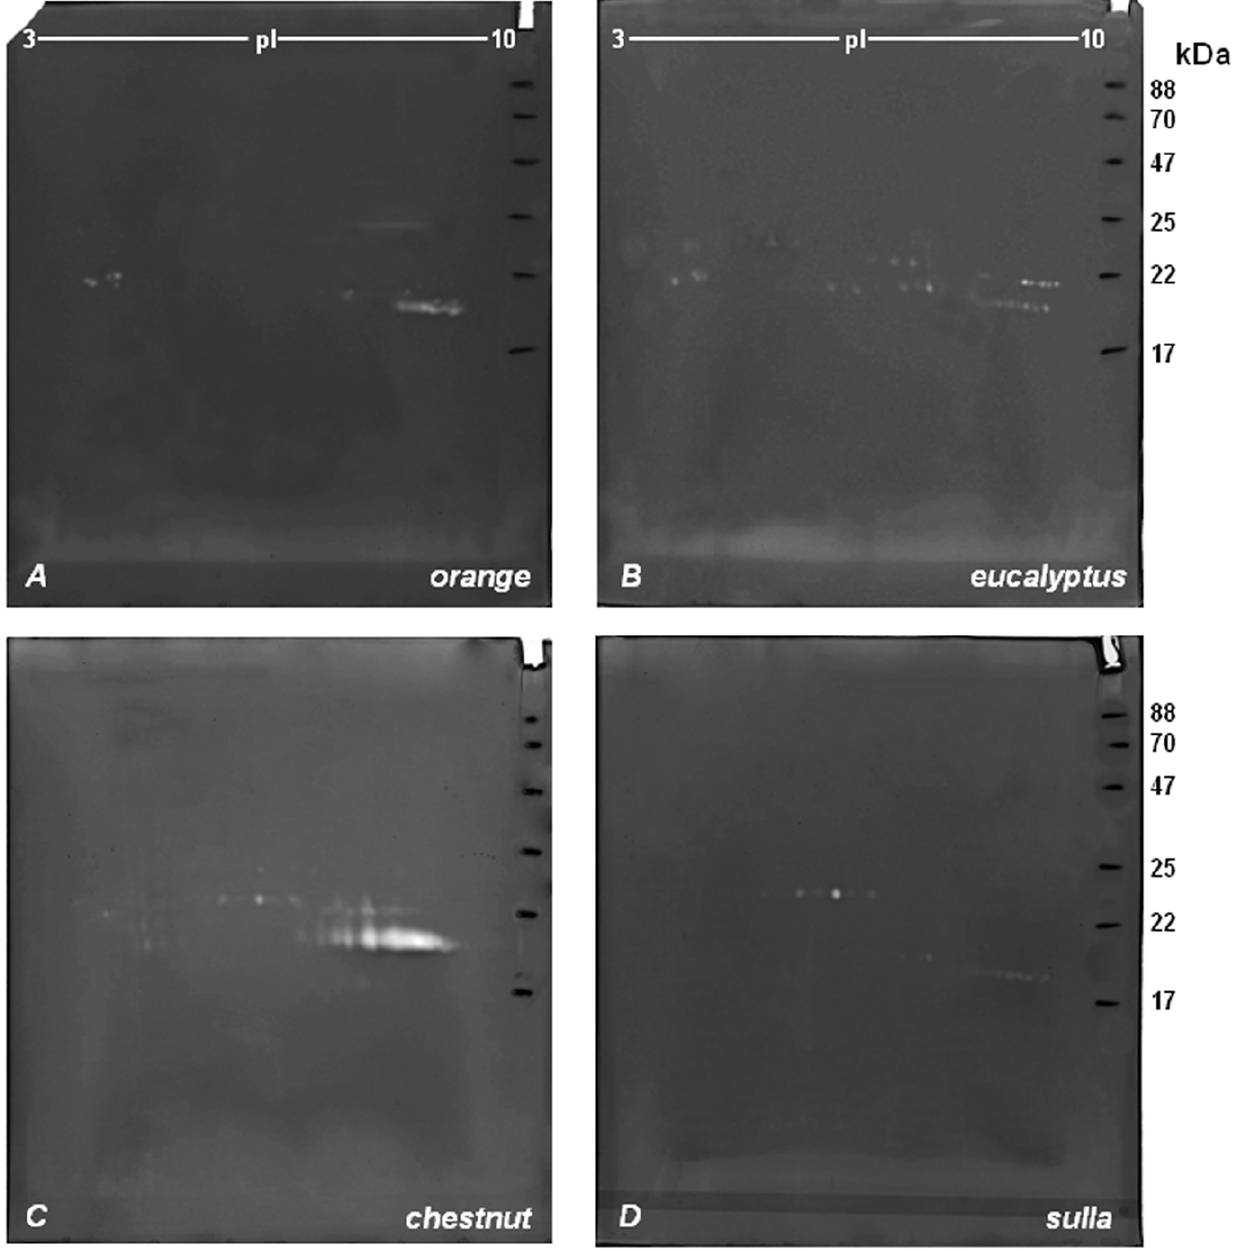
Figure 1. 2-D zymography (2-DZ) of the proteolytic activities present in honey MT1 extracts. Proteolytic activities were detected by 2-D zymography on gels copolymerized with gelatin. Gels: A ( orange honey), B ( eucalyptus honey), C ( chestnut honey) and D ( sulla honey). 80 m g of proteins were applied to each gel.